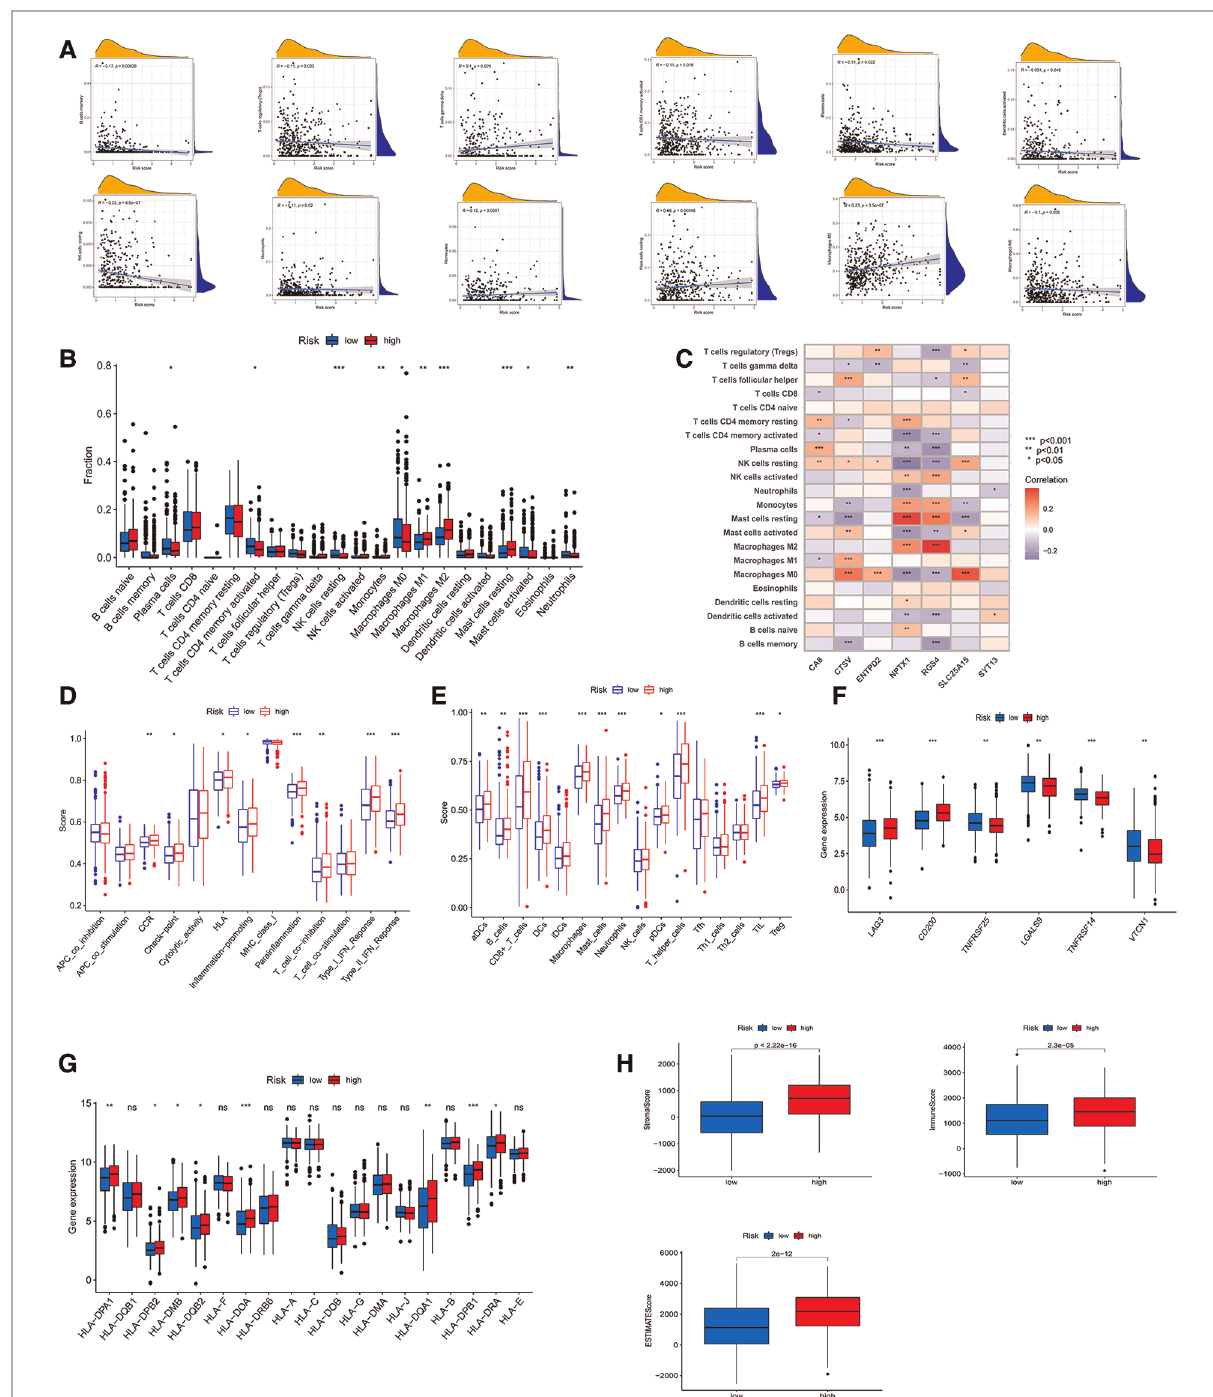
FIGURE 7 ( A ) correlative analysis between risk score of immune cells. ( B ) TME cells in fi ltration in low- and high-CRG_score groups by CIBERSORT algorithm. ( C ) Associative analysis between 22 immune cells and risk genes. ( D,E ) ssGSEA algorithm calculating the scores of immune cells in fi ltration in the risk groups. ( F ) Differential expression of immune checkpoints in the two CRG_score groups. ( G ) The diagram showing the expression of HLAs in the two risk groups. ( H ) The stromal, immune, ESTMATE scores of low- and high-CRG_score groups using ESTMATE